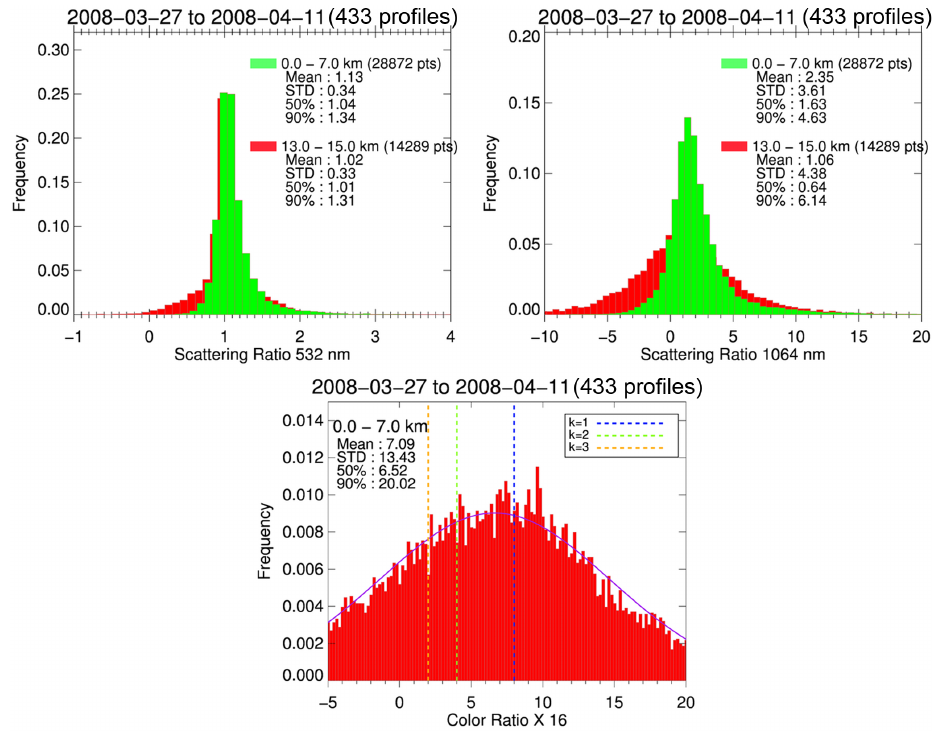
Figure 8. Distribution of the 532nm (top left) and 1064nm (top right) filtered level 1 CALIOP backscatter ratios at altitudes from 0 to 7km (green) and 13 to 15km (red) from 27 March to 11 April in the aircraft flight area. Mean, standard deviation, median and 90th percentile are given for each distribution. The distribution of the aerosol colour ratio 16 × CR a (bottom) is compared to the lines for CR a = 0 . 125 ( k = 3), CR a = 0 . 25 ( k = 2) and CR a = 0 . 5 ( k =